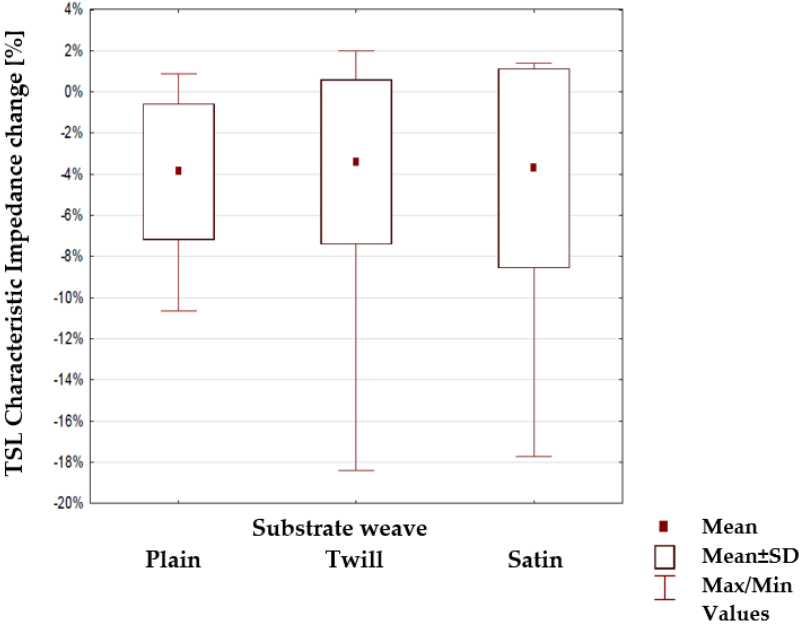
Figure 13. Changes in the line characteristic impedance under load for lines with a different weave of the substrate.